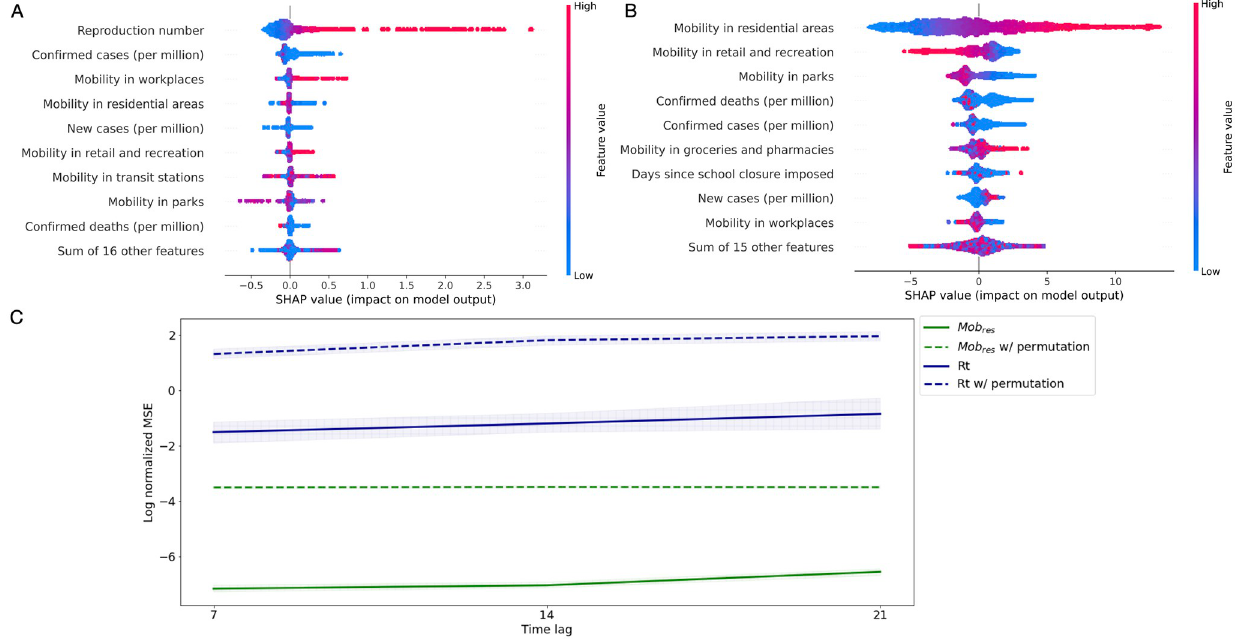
Fig 4. Important predictors of outcome and accuracy of prediction for different time-lags. (A) Identification of top-10 predictive variables affecting R t estimation. (B) Top-10 most contributing features for residential mobility estimation. SHAP analysis in A and B is based on predictions using a time-lag of 7 days. Each dot represents a single data sample in the validation set (i.e., country at a date). The dot color represents the feature value (red = high, blue = low). The farther a dot is from 0 on the x-axis, the more effect (positive or negative) this feature had on the prediction model for this particular sample. (C) Model performance (log of normalized MSE) of R t (solid dark blue line) and residential mobility (solid green lines) in the validation set for different time lags. The dashed lines of the same color correspond to random prediction derived by permutation tests with their respective models. Both models significantly outperformed random